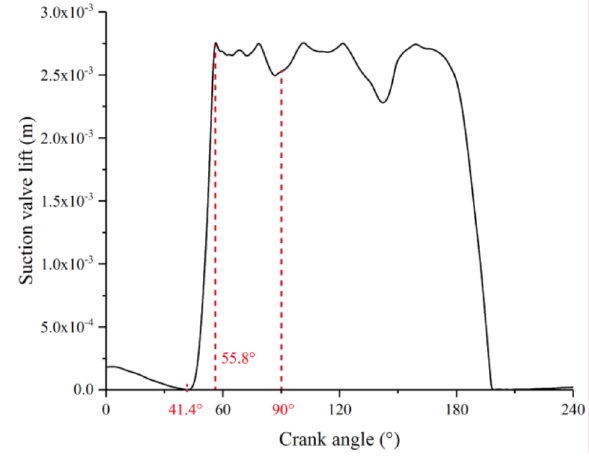
Figure 13. Three characteristic crank angles.